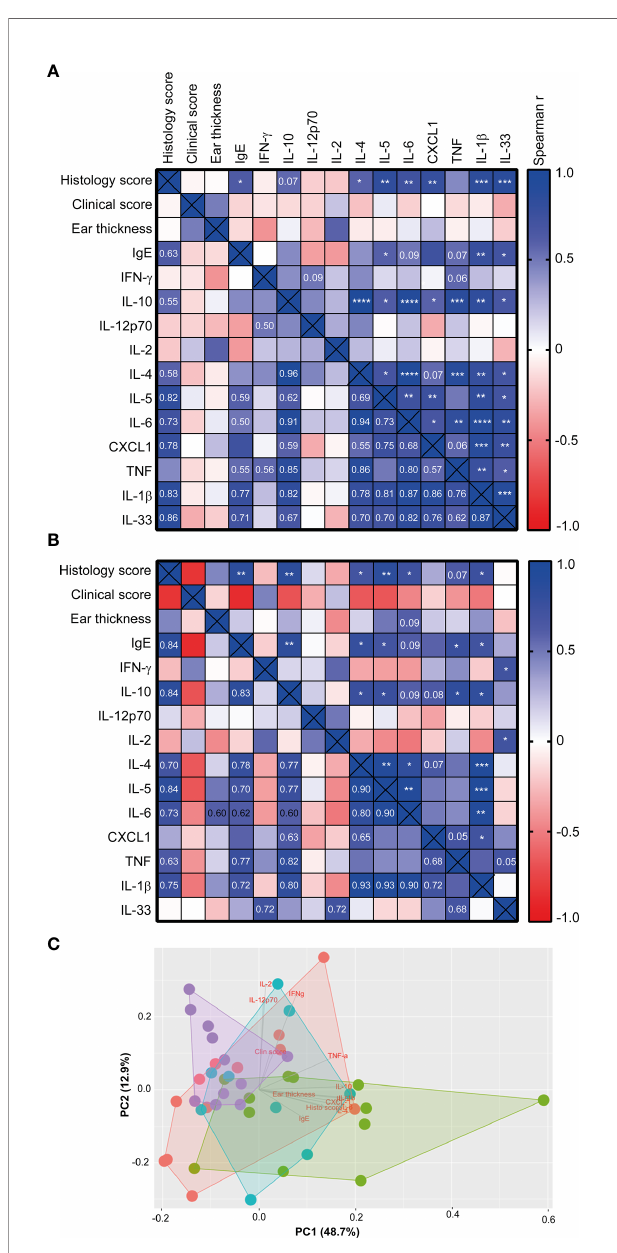
FIGURE 3 | The histology score correlated with the immune response of high-responding mice Heatmaps illustrating signi fi cant correlations between phenotypic disease markers used to characterize disease development and immunological responses in the 1W group ( n =12) (A) , and in the 8W group (B) . P-values are indicated in the upper right half of the heatmaps and the r 2 values are given in the lower left halfs for correlations with p-values < 0.1. The color codes indicate the positive or negative r value (correlation). (C) Principal component analysis plot based on the phenotypic disease and immune markers listed in (A) , showing clusters of SPF ( n =11, purple), 0W ( n =12, red), 1W ( n =12, green) and 8W ( n =9, blue) mice. * indicates p < 0.05, ** indicate p < 0.01, *** indicate p < 0.001, **** indicate p <